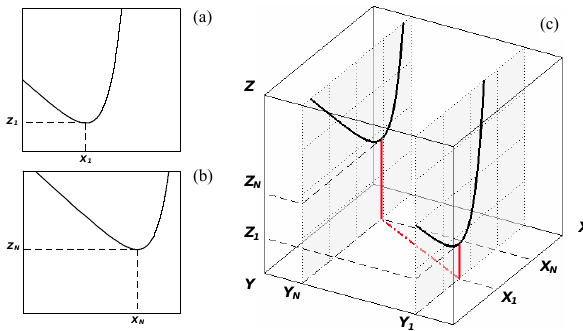
Figure 8 Hypothetical pattern for the general impact of data time interval on forecasting Fig. 8. Hypothetical pattern for the general impact of data time in- accuracy and the selection of the optimal time interval in real-time hydrological forecasting. terval on forecasting accuracy and the selection of the optimal time The axes of X, Y and Z respectively stand for the time interval of the model input data, the interval in real-time hydrological forecasting. The axes of X , Y and forecast lead time and the forecasting error. Z respectively stand for the time interval of the model input data, the forecast lead time and the forecasting